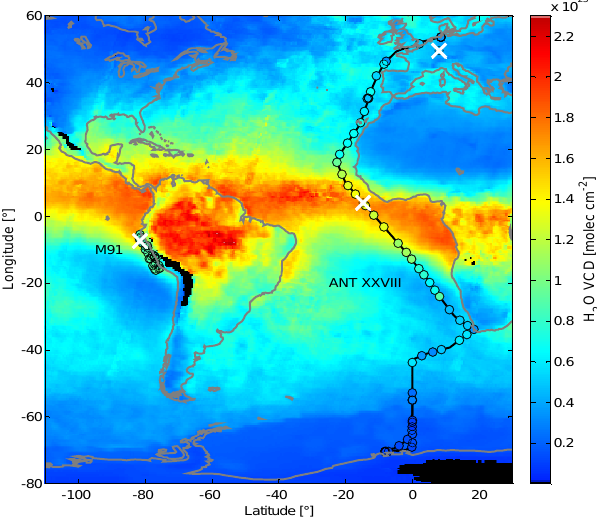
Figure 2. Measurement overview: the cruise track of M91 (Peru- vian Upwelling) and ANT XXVIII/1-2 (Atlantic) is shown; addi- tionally, the location of the LP-DOAS measurements in Heidelberg, Germany, is marked (white cross in the north-eastern corner of the map). The background shows GOME-2A H 2 O vertical column den- sities (VCDs) (Wagner et al., 2003) averaged from November to December 2011 (time during ANT XXVIII/1-2). The locations of the measurements shown in Figs. 3 and 5 are also marked by white crosses. Daily error-weighted averages of H 2 O / O 4 dSCD ratios (measured in the wavelength range from 340 to 380nm at 3 ◦ tele- scope elevation, corrected according to Fig. 6) are shown as circles and converted to a VCD assuming an exponential water vapour con- centration profile with a scale height of